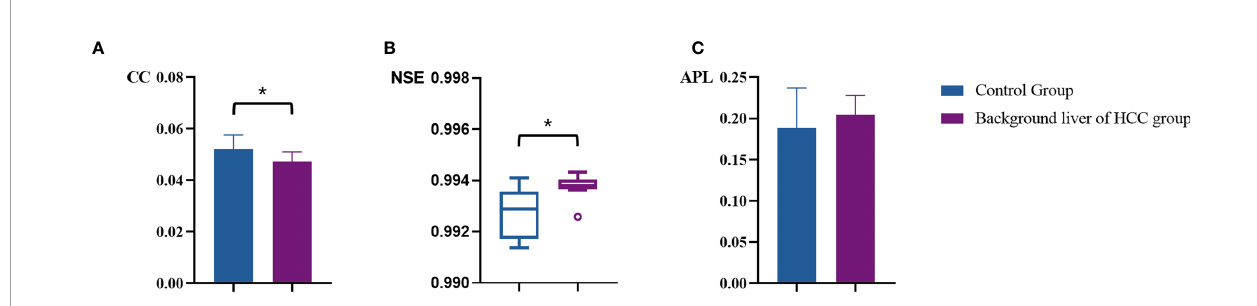
FIGURE 5 | Comparison of vascular parameters (A) CC, (B) NSE and (C) APL of the control group and the background liver of HCC group. * p